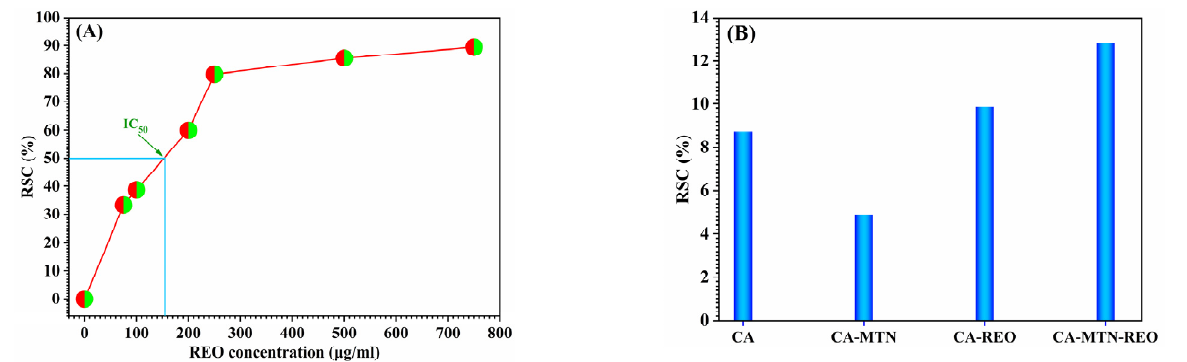
Figure 6. DPPH-scavenging activities of rosemary essential oil ( A ) and of unloaded and REO loaded CA and hybrid CA-MTN microcapsules ( B ).